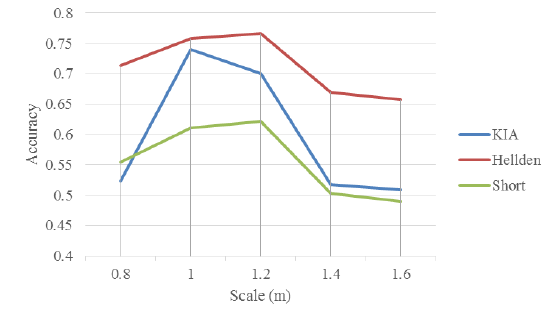
Figure 7 Trend graph of extraction accuracy with the change of